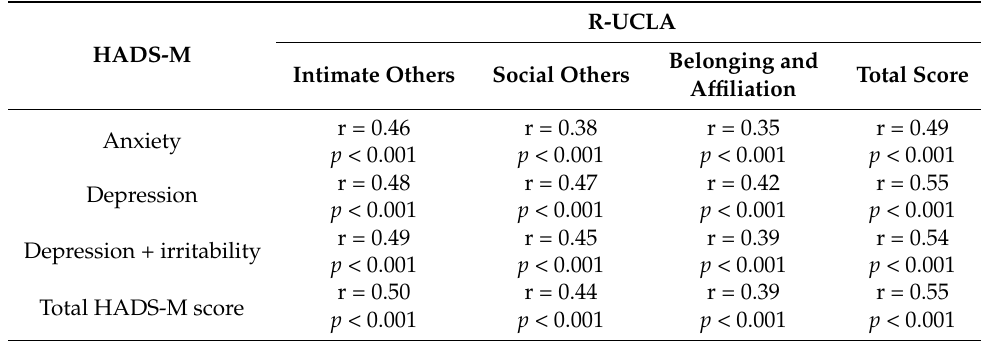
Table 3. Correlations between loneliness and anxiety, depression, and